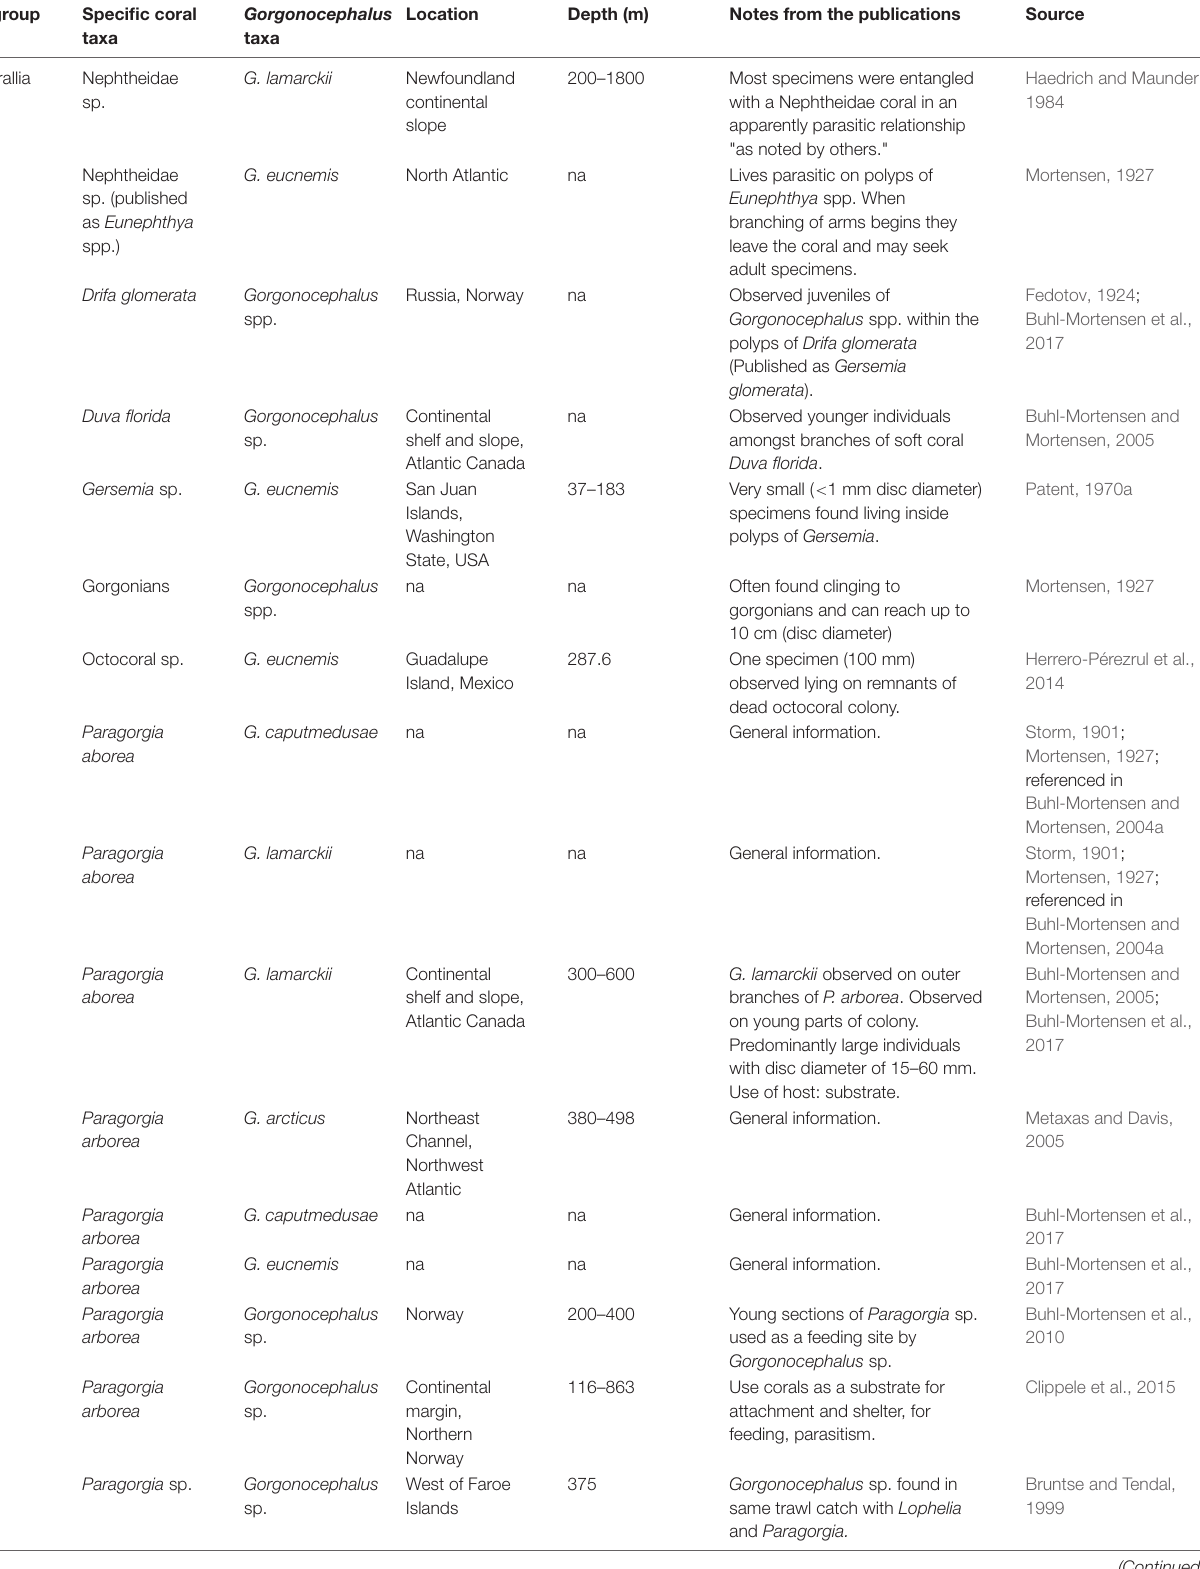
TABLE 1 | Reported associations between Gorgonocephalidae basket stars and cold-water